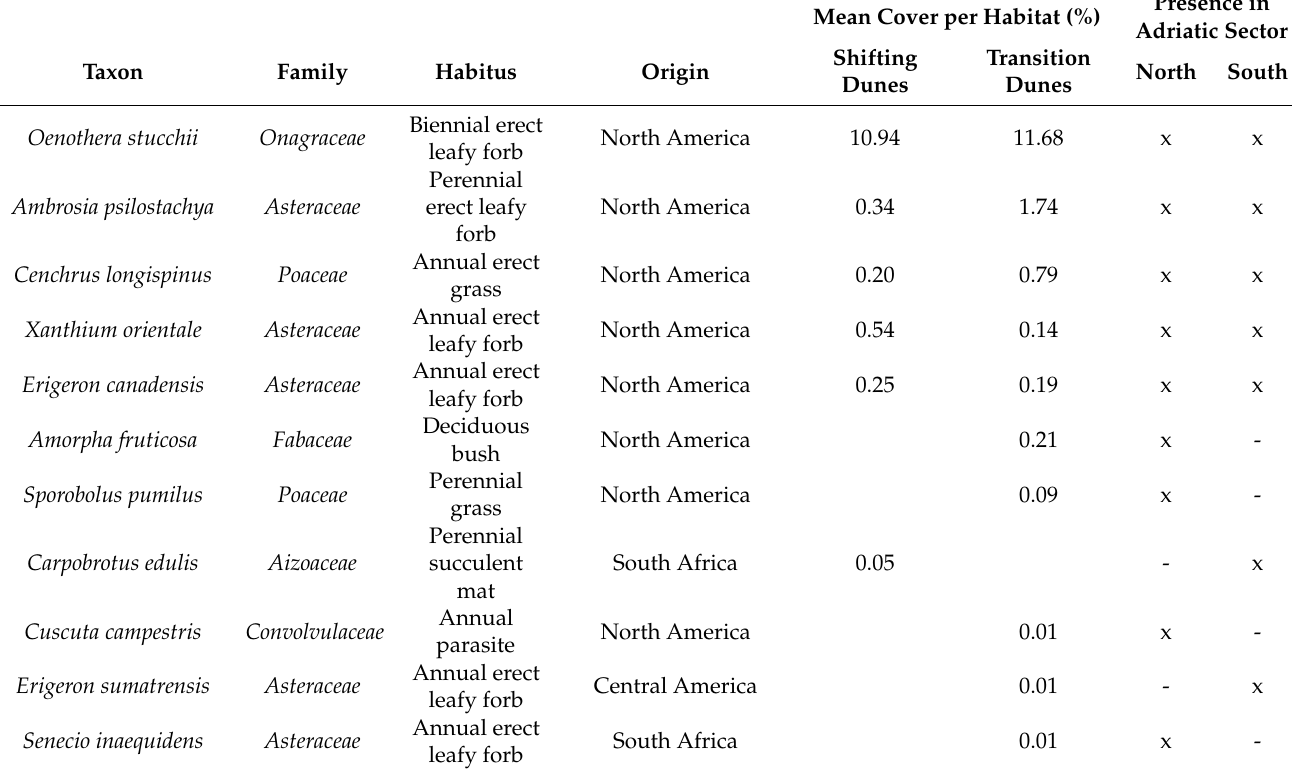
Table 1. List of IAP found in shifting and transition dunes in the study area. For each taxon, the family, the habitus and the geographical origin are reported, alongside the mean cover per habitat and the presence in the corresponding Adriatic sector.